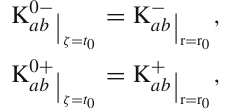
smoothness at the matching surfaces. For that we must